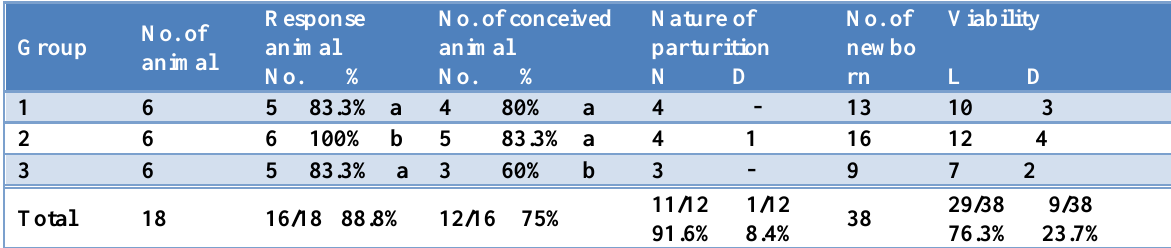
Total N= normal, D=Dystocia, L=Alive, D=Dead. *different letters means significant differences